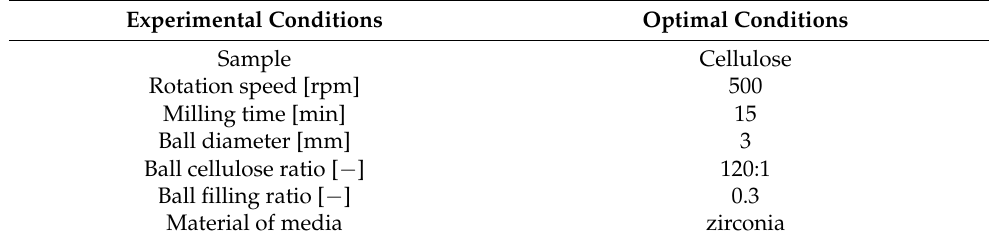
Figure 3. Scheme of method B. Table 1. Optimal experimental conditions for the